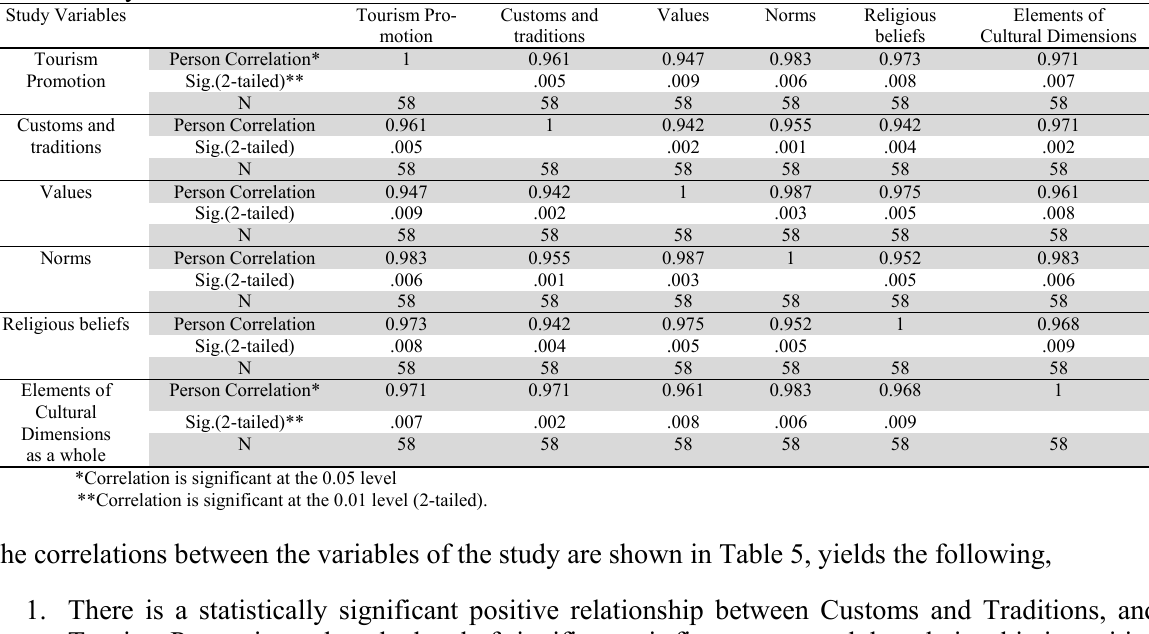
The summary of correlations